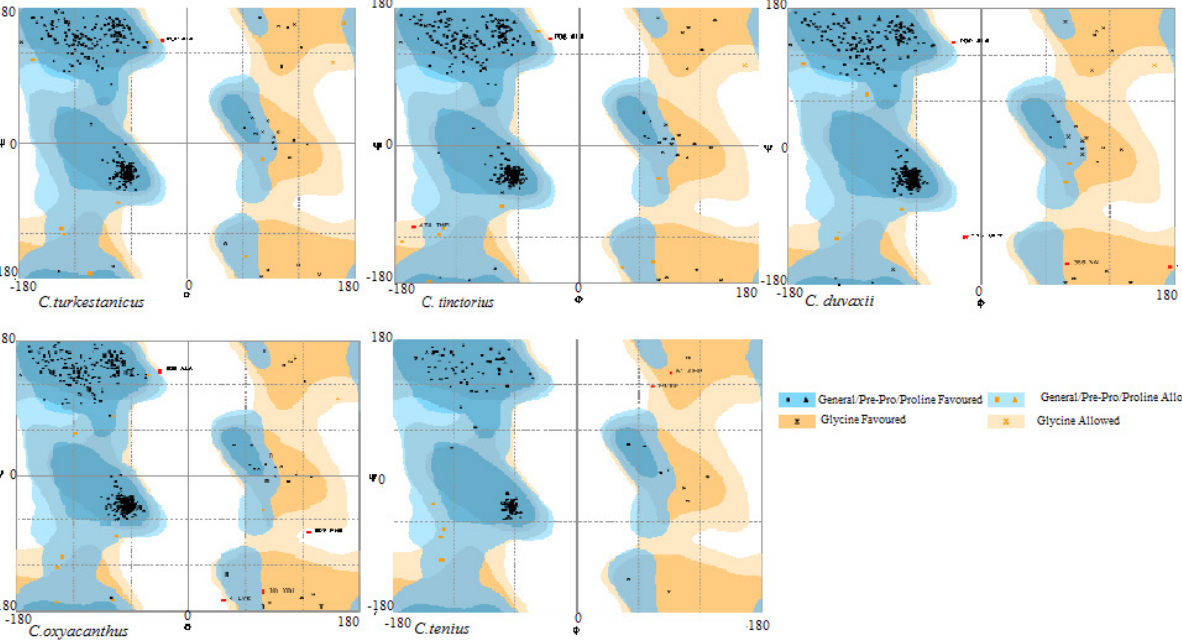
Fig. 5. Ramachandran plots of Carthamus ssp. RuBisCO proteins by using Rampage